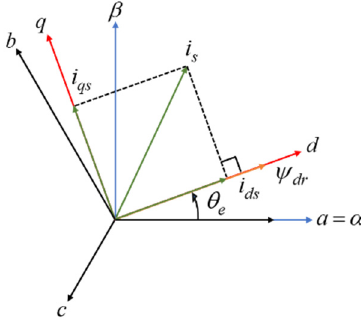
Figure 2. Phasor diagram of FOC’s drive system.